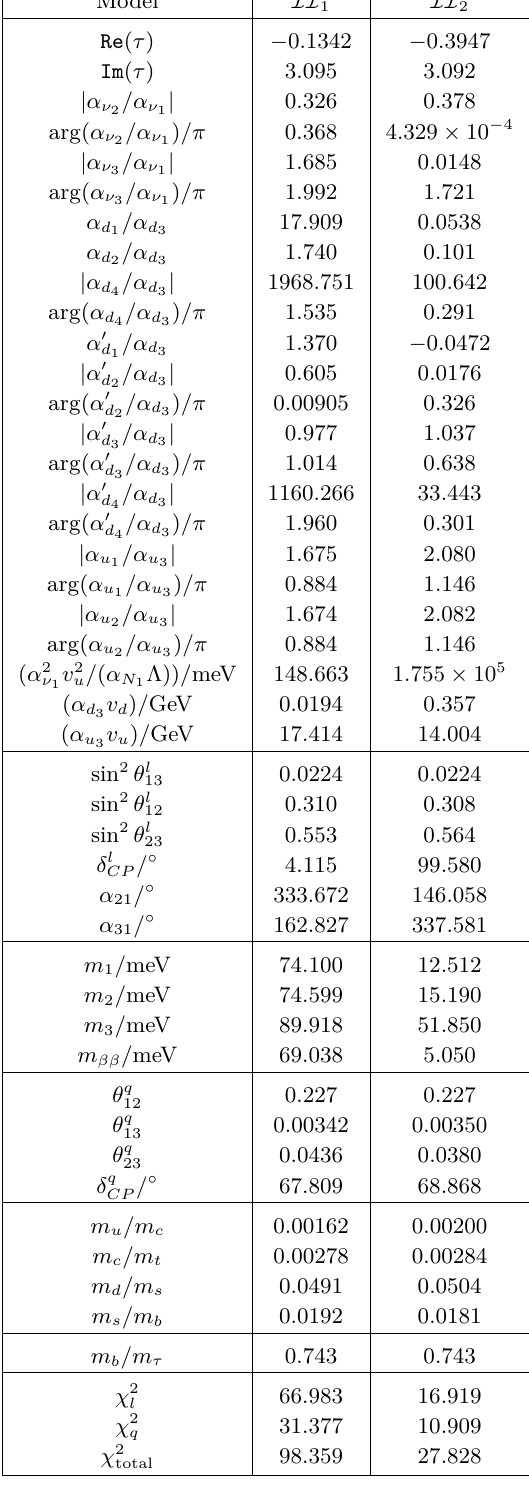
Table 8 . The best fit values of the free parameters and the corresponding predictions for lepton and quark mixing parameters and fermion masses for the phenomenologically viable models of